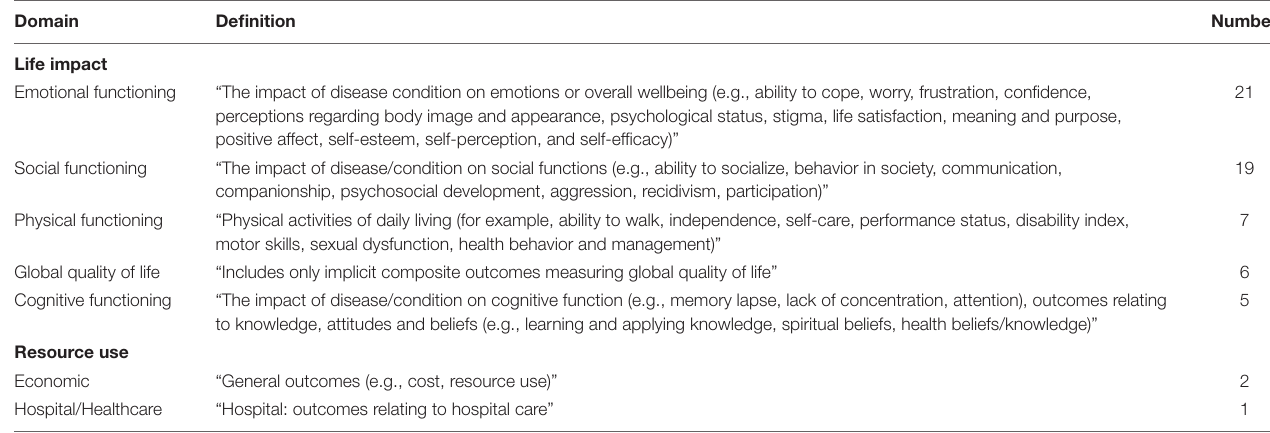
TABLE 4 | Outcomes measured using taxonomy by Dodd et al.